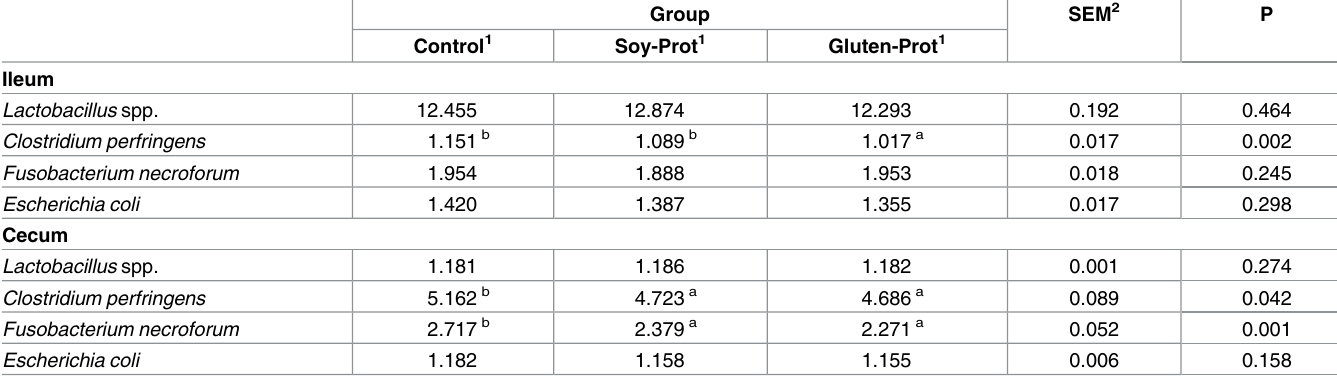
Table 8. Results per microbial pathogen and experimental group recorderby PCR and expressedin arbitrary units (AU).